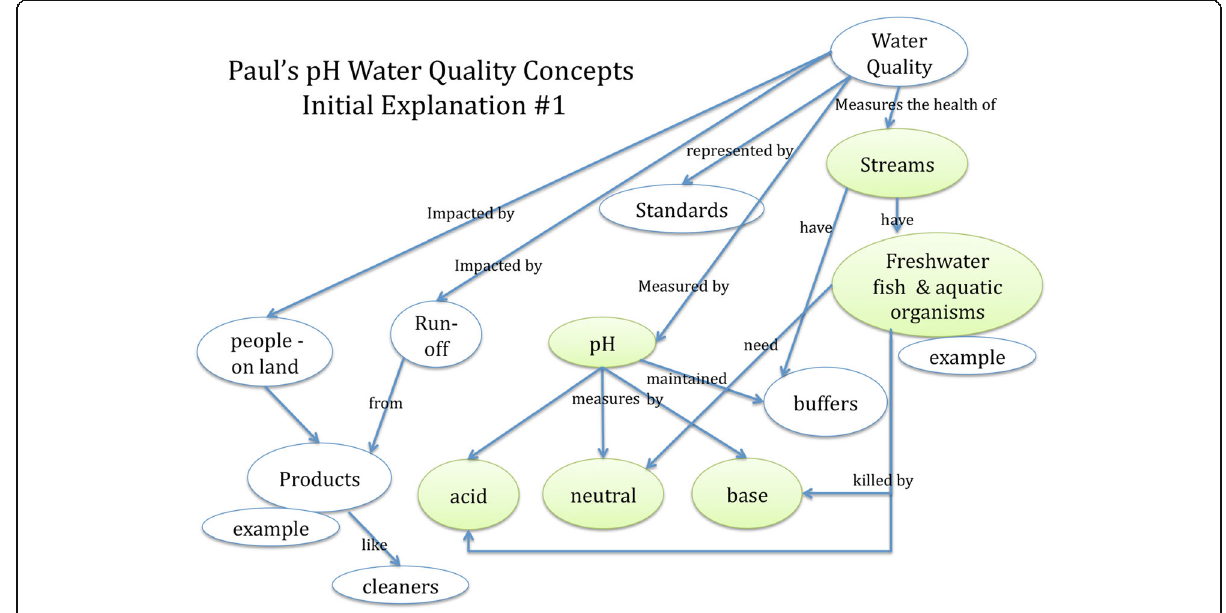
Fig. 2 Paul ’ s Initial Explanation: Rubric Score - 2/6 points